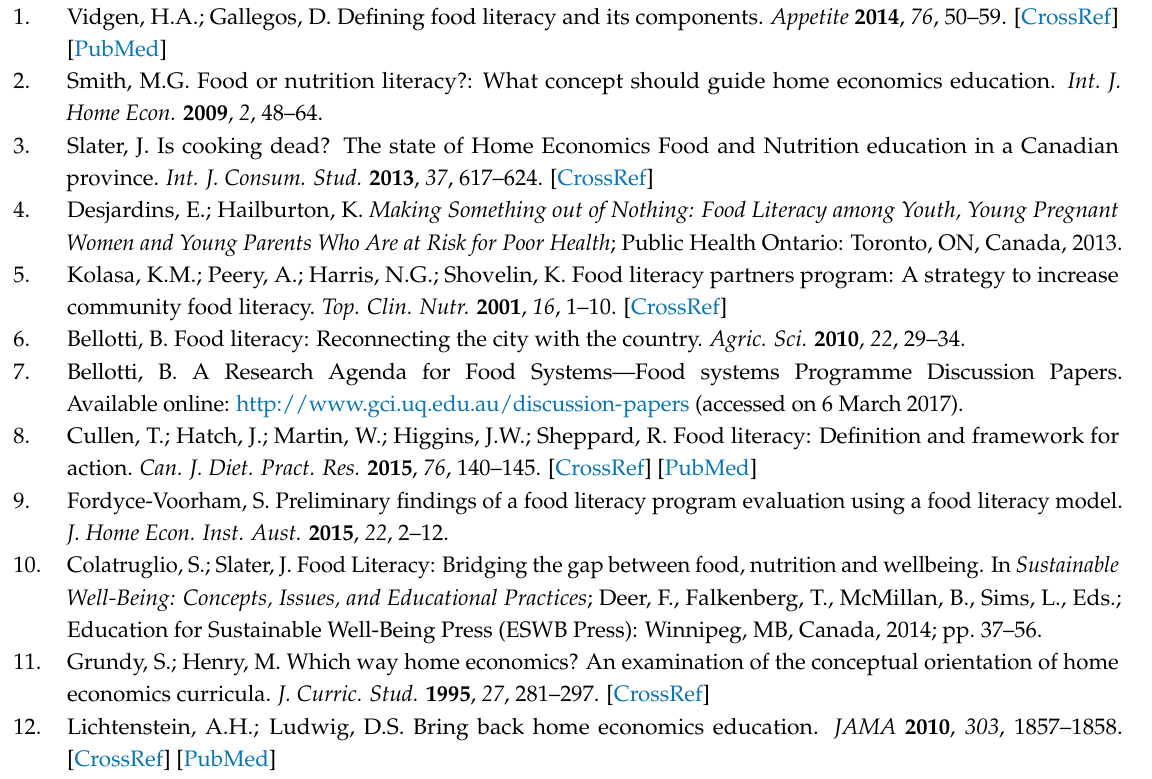
s1: Figure S1. The model of stakeholder involvement in secondary school food literacy education, Figure S2. Leximancer concept map, Table S1. Percentages of respondents who agreed with the inclusion of different topics in the food literacy curriculum for senior secondary school students (years 11 and 12), Table S2.